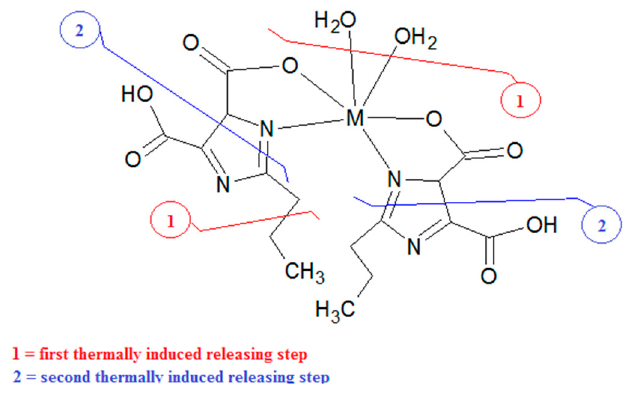
Figure 3. Scheme of the general decomposition mechanism.